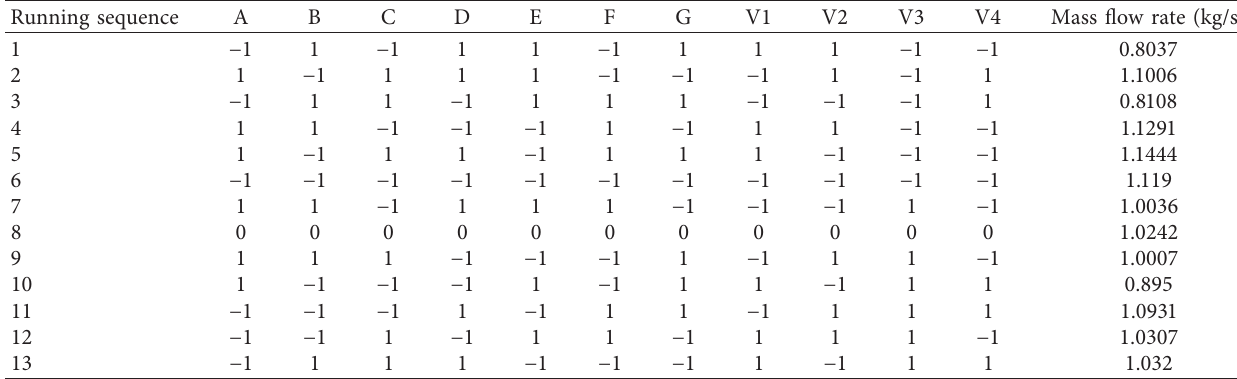
Table 3: Design and results of Plackett-Burman experiment.